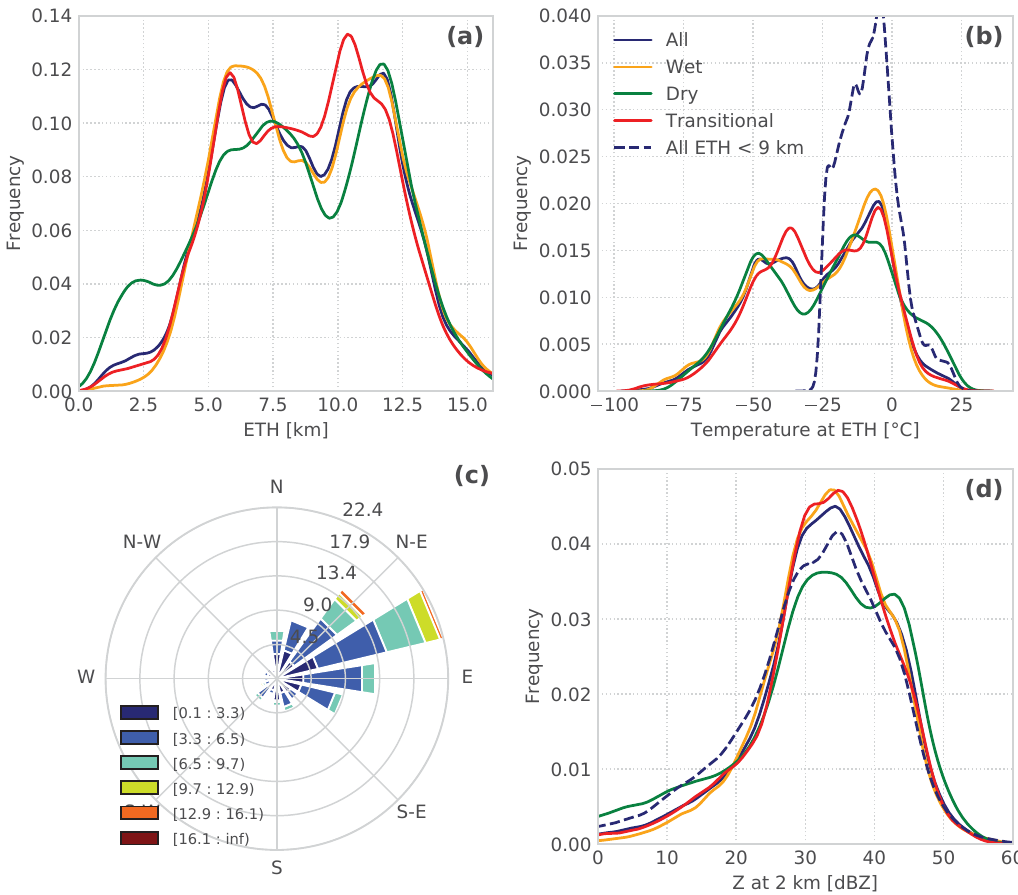
Figure 5. Histograms associated with RWP classification-based convective DSDs in terms of ETH (a) , temperature at ETH (b) and Z at 2km (d) for all, dry, wet and transitional seasons, as well as the congestus for all the seasons. The wind rose (c) is also shown for all the